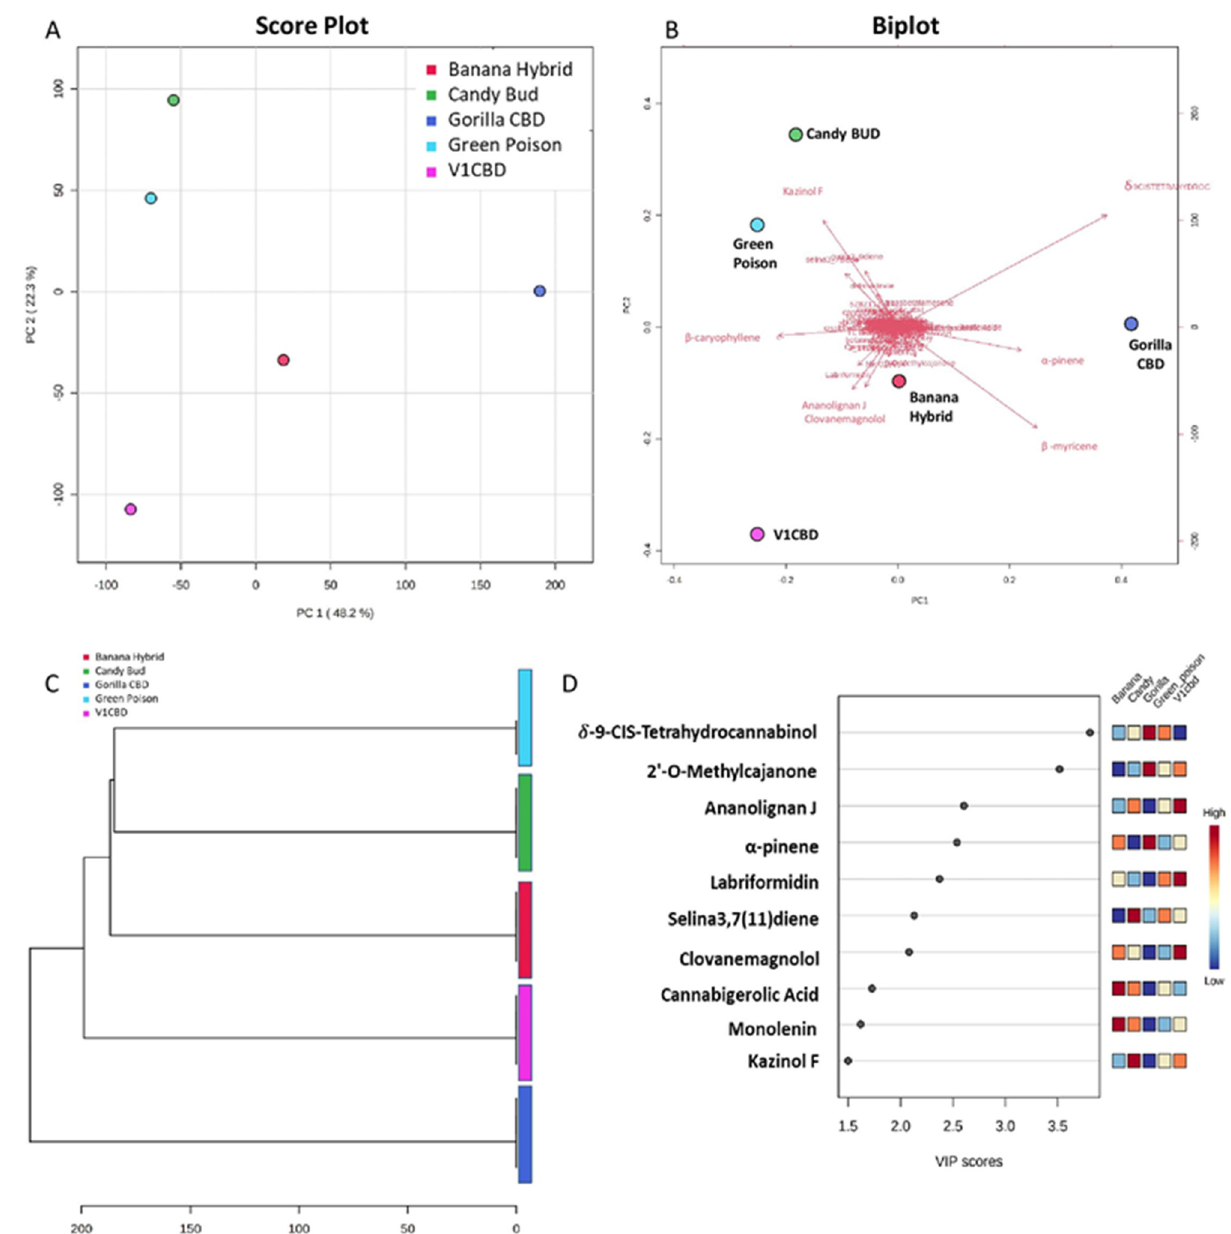
Figure 3. ( A ). Principal component Analysis (PCA) Score Plot. Two dimensional 2D PCA scores plot demonstrates statistical clustering for C. sativa inflorescences cultivars. ( B ). Principal component Analysis (PCA) BiPlot. A biplot provides information on both metabolites and samples of a data matrix to be displayed graphically. Metabolites grouped at the origin of the graph do not contribute to samples variability. ( C ). Hierarchical clustering (HCA). It shows the dendrogram based on Euclidean distance. ( D ). PLS-DA and Variable importance in projection (VIP) plot. It displays the top 10 most important metabolite features identified by PLS-DA. Colored boxes on right indicate relative mean percentage of corresponding metabolite for C. sativa inflorescences. VIP is a weighted sum of squares of the PLS-DA loadings considering the amount of explained Y-variable in each dimension. VIP-plot (Figure 3D) analyzed ten metabolites with VIP score between 1.5 and 3.5